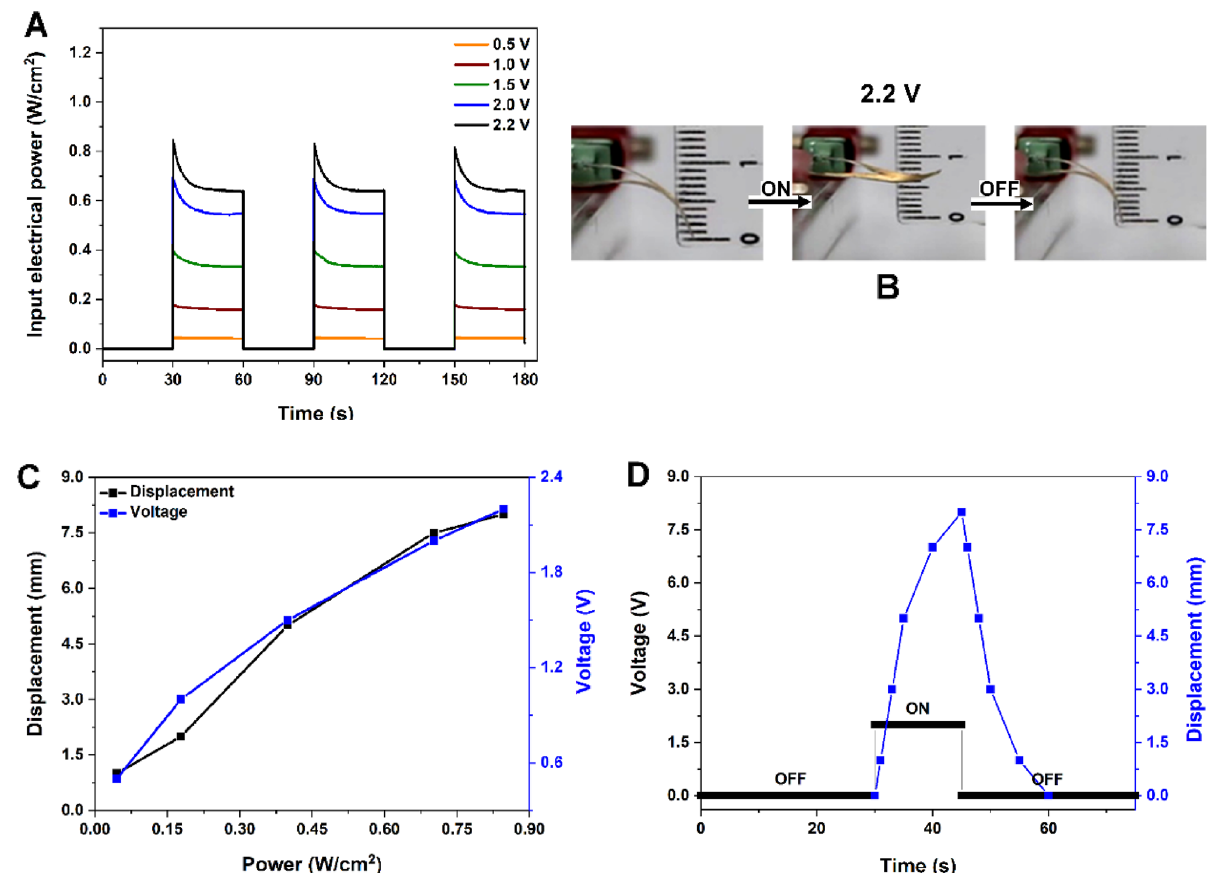
Figure 1. Actuation process: ( A ) the input electrical power versus time and ( B ) snapshots taken during the Au/ Nylon-PDMS movement at 2.2 V; ( C ) maximum displacement and voltage versus input electrical power; ( D ) displacement behavior versus one applied ON/OFF voltage